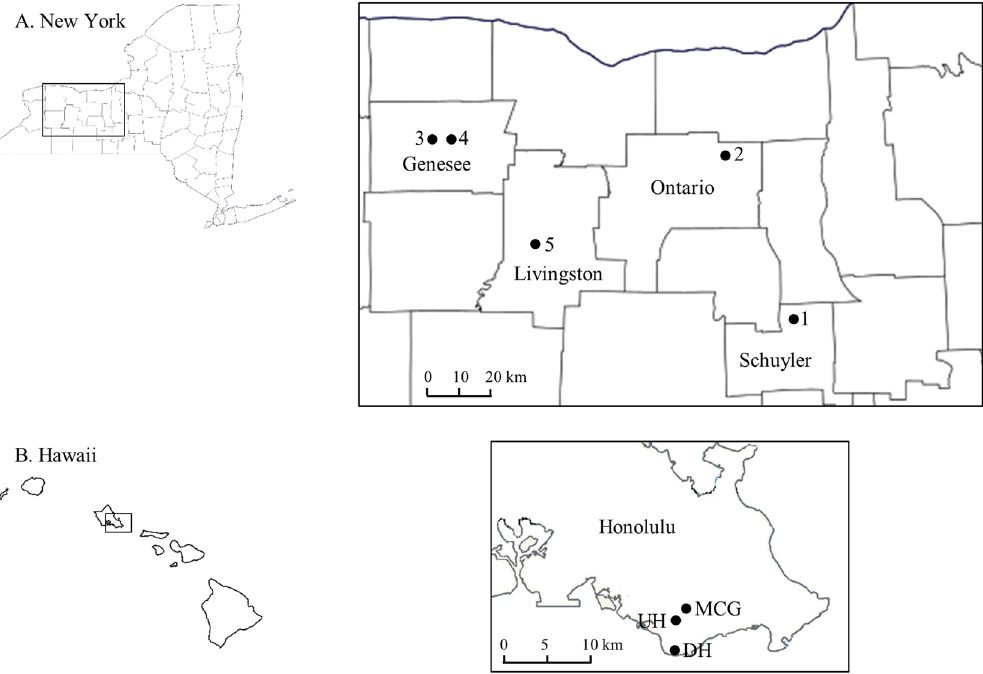
Figure 1. Sampling locations for Cercospora beticola populations collected in 2015 from ( A ) New York and ( B ) Hawaii. Numbers 1, 2, 3, 4, and 5 in New York represent Farm 1, Farm 2, Field 3, Field 4 and Field 5, respectively. In Hawaii, MCG, UH and DH represent community gardens in Honolulu (MCG = Manoa community garden, UH = University of Hawaii organic garden, and DH = Diamond Head community garden). The map presented here are modified from https://commons.wikimedia.org/wiki/File:Map_of_New_York_ County_Outlines.svg and https://upload.wikimedia.org/wikipedia/commons/e/e5/Interstate_H1_map.png. Figures were produced in Microsoft Paint and Microsoft PowerPoint 2013.